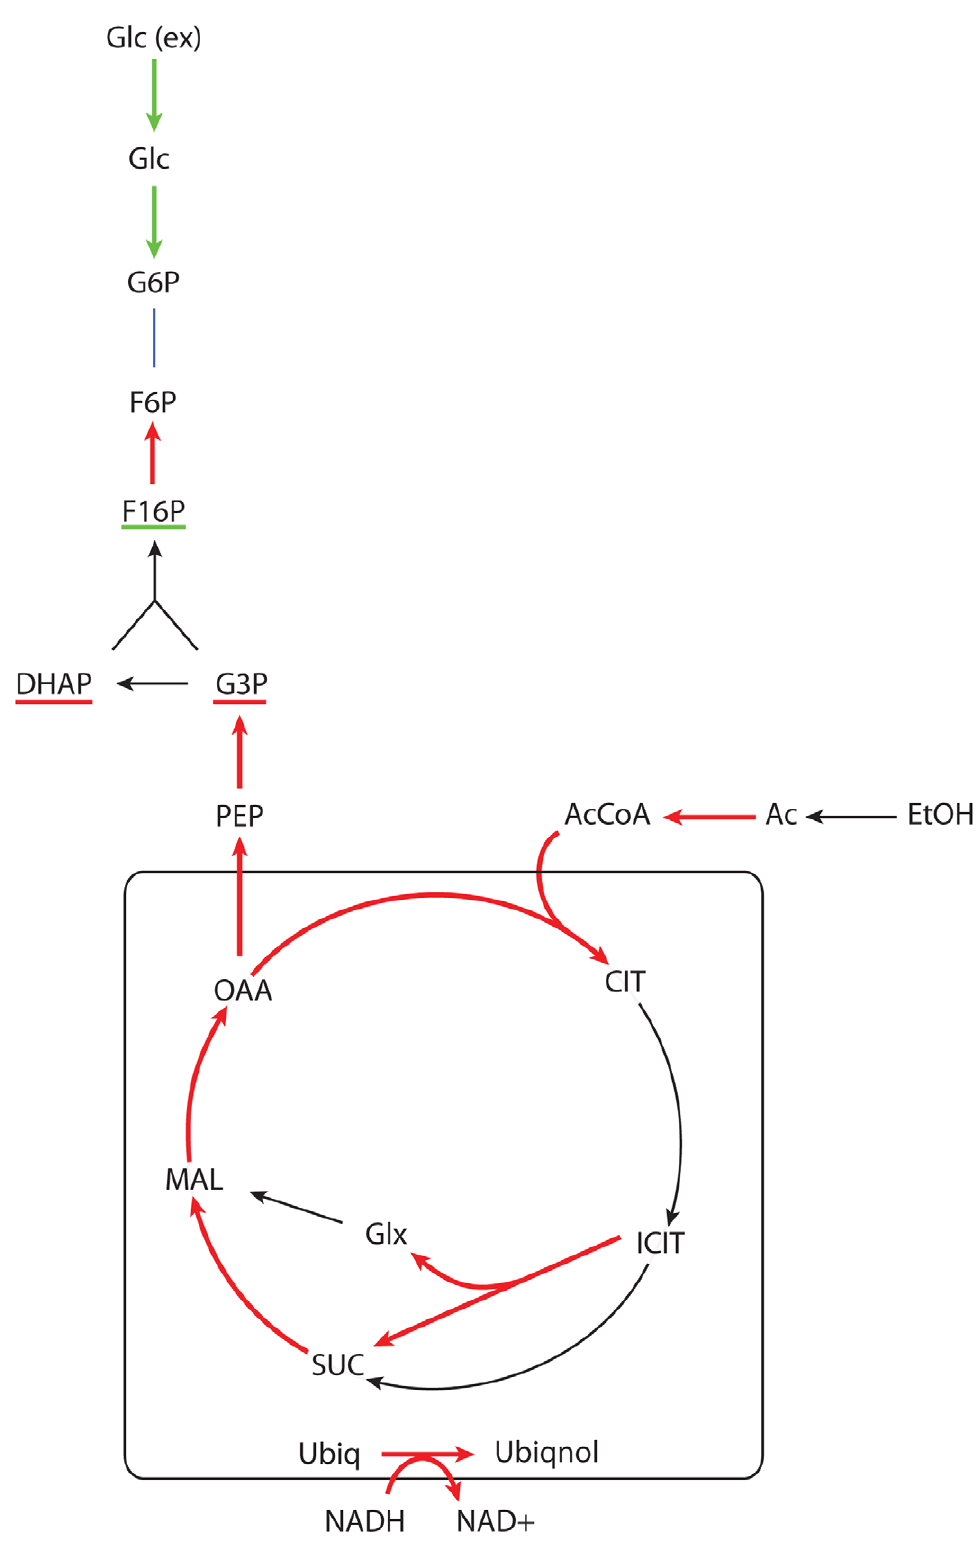
Figure 4. Main reactions showing transcriptional up (red) or down (green) regulation associated with the glucose-ethanol shift. The underlined metabolite pools are those that are expected to increase (red) or decrease (green) according to the observed metabolic regulation.